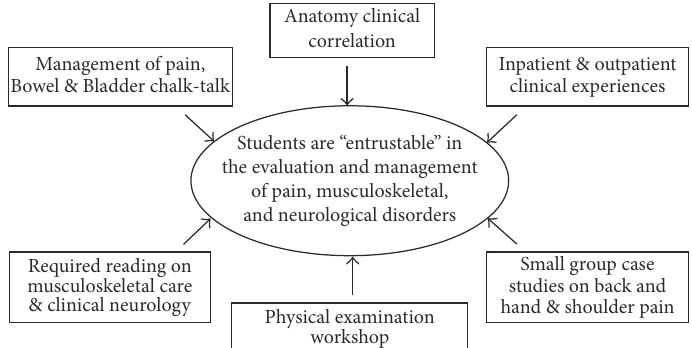
Figure 2: Conceptual framework for the revised two-week required PM&R clerkship for fourth-year medical